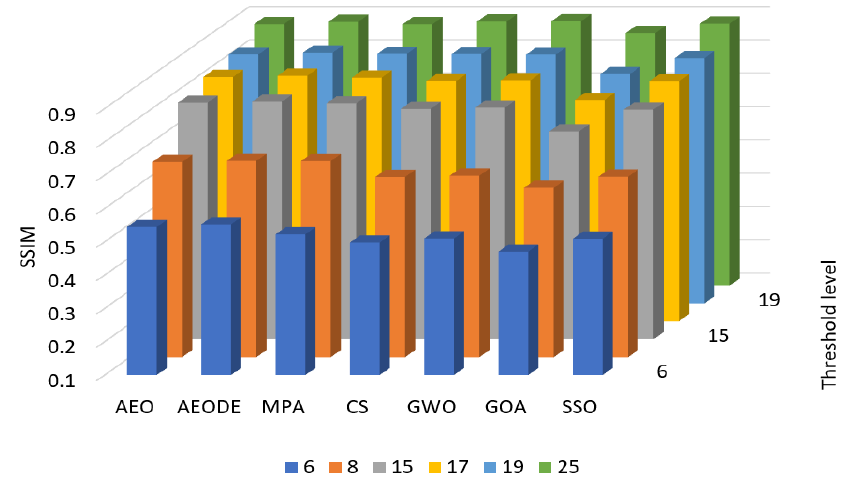
Figure 3. SSIM at different threshold levels.